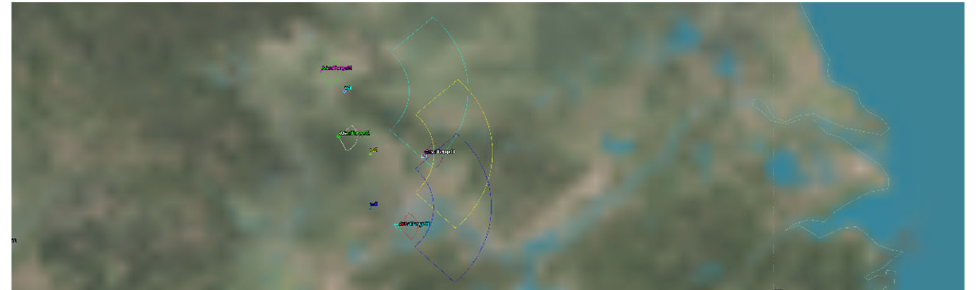
Figure 4. 2D schematic diagram of operational scenarios.